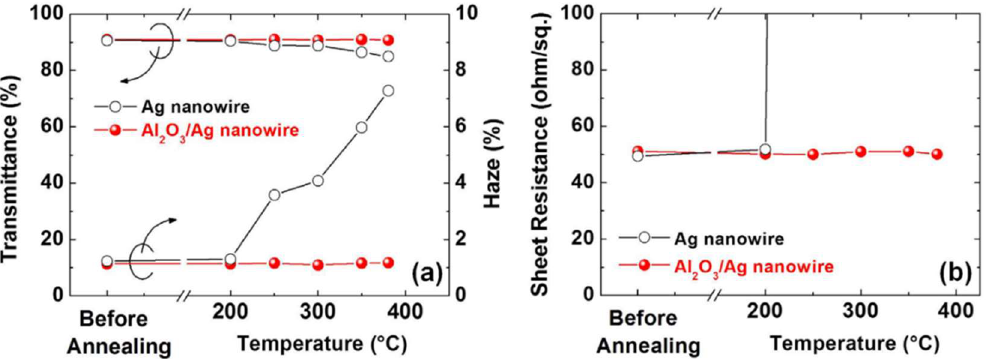
Figure 8. Changes in ( a ) optical transmittance/haze and ( b ) sheet resistance of the Ag and Al 2 O 3 /Ag nanowire electrodes as a function of the annealing temperature. The annealing time is 20 min. Reprinted from [5], with permission from Springer Nature Limited , 2017.